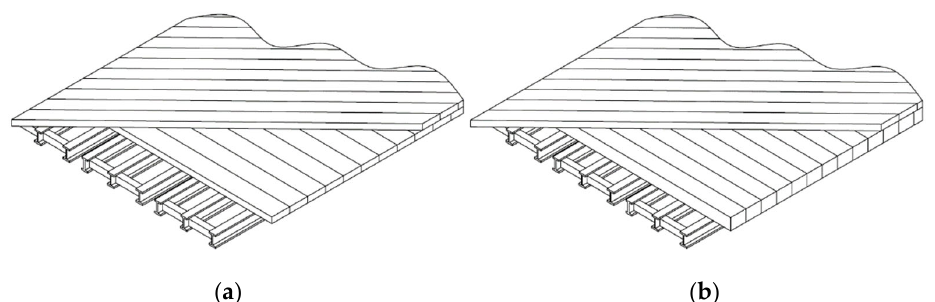
Figure 6. Two alternatives of timber roadway deck: ( a ) standard solution of timber deck; and ( b ) more stiff timber deck.